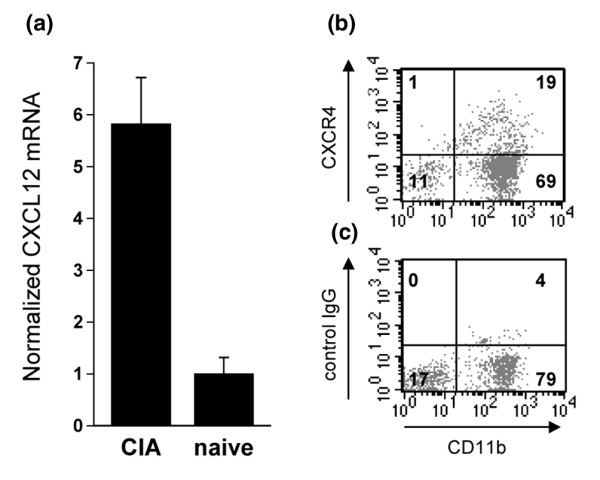
Presence of CXCL12 RNA and CXCR4+ cells in the arthritic joint. (a) Synovia of three collagen type II/complete Freund's adjuvant-immunized collagen-induced arthritic (CIA) mice and three naive mice were isolated on day 35 after immunization and total RNA was purified. Reverse-transcription was performed and cDNA was subjected to quantitative PCR and normalized to the amount of 18S RNA. (b) Joints of three other collagen type II/complete Freund's adjuvant-immunized mice were washed at day 35 with PBS/FCS 2%. Cells that were harvested from the joint were stained for the presence of CD11b using fluorescein isothiocyanate (FITC)-labeled antibodies, and for CXCR4 using phycoerythrin (PE)-labeled antibodies. (c) Control staining for CXCR4 using a PE-labeled rat IgG2b isotype control antibody. One representative experiment out of two is shown.